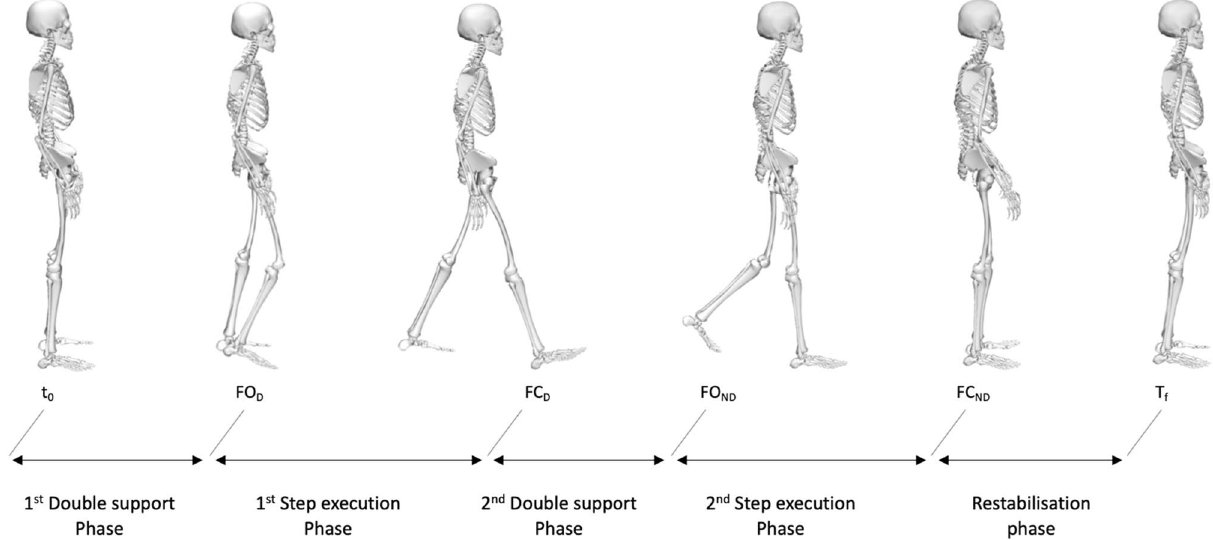
Figure 1. Representation of the step execution movement phases. t 0 the onset of the movement, FO D foot-off of the dominant leg, FC D foot-contact of the dominant leg, FO ND foot-off of the non-dominant leg, FC ND foot- contact of the non-dominant leg, T f the end of the stepping